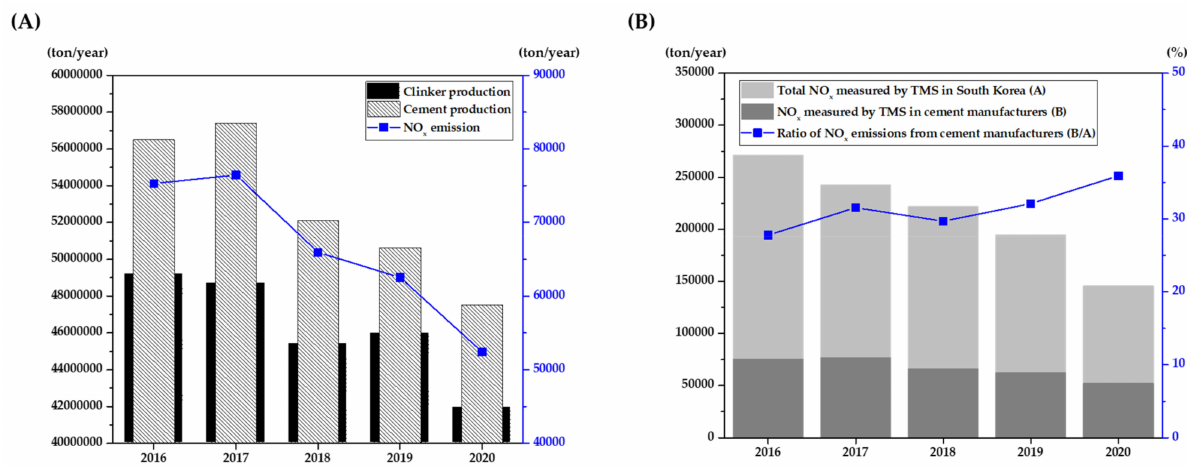
Figure 7. ( A ) NO x emissions according to clinker and cement production in South Korea; ( B ) Ratios of NO x emission from Korean cement manufacturers (Units: ton/year, %) (data taken from [15,16]). The NO x emission standard specified for Korean cement manufacturers is 270 ppm or less for kilns installed before 31 January 2007, as shown in Table 2. For kilns installed between 1 February 2007 and 31 December 2014, it is 200 ppm or less, and for those installed after 1 January 2015, it is 80 ppm or